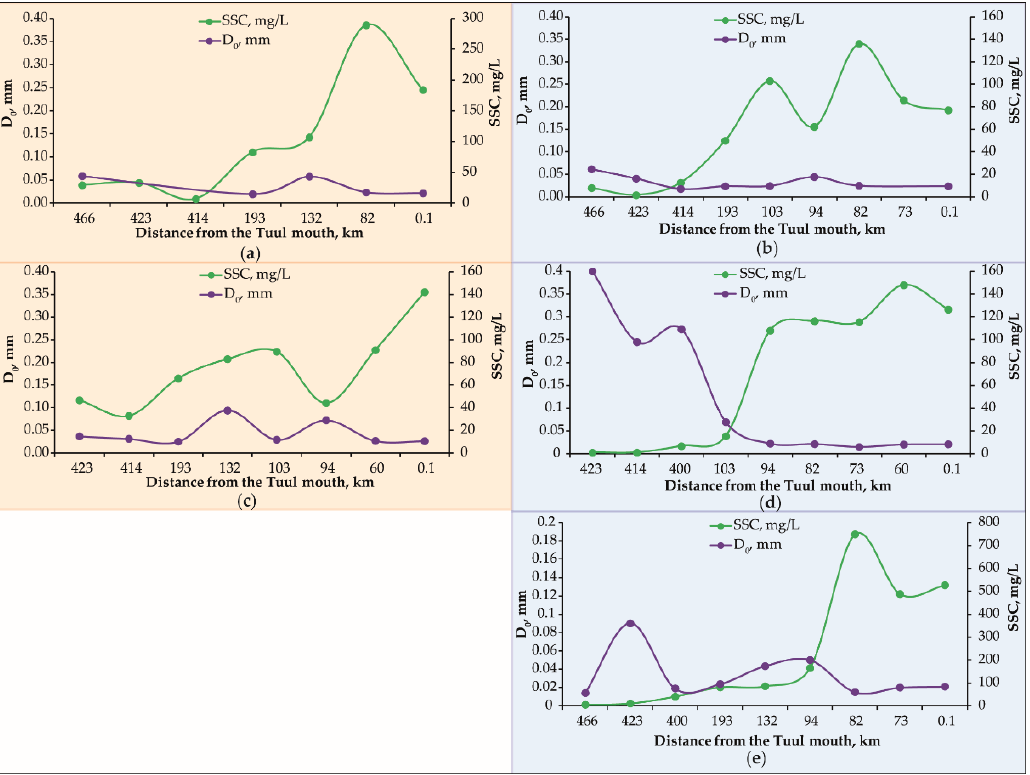
Figure 3. Suspended sediment concentrations ( SSC ) and grain size along Tuul River in different hydrological seasons: ( a ) 2011 HW, ( b ) 2012 LW, ( c ) 2013 HW, ( d ) 2014 LW, ( e ) 2016 LW. Orange background indicates HW conditions, blue background—LW.